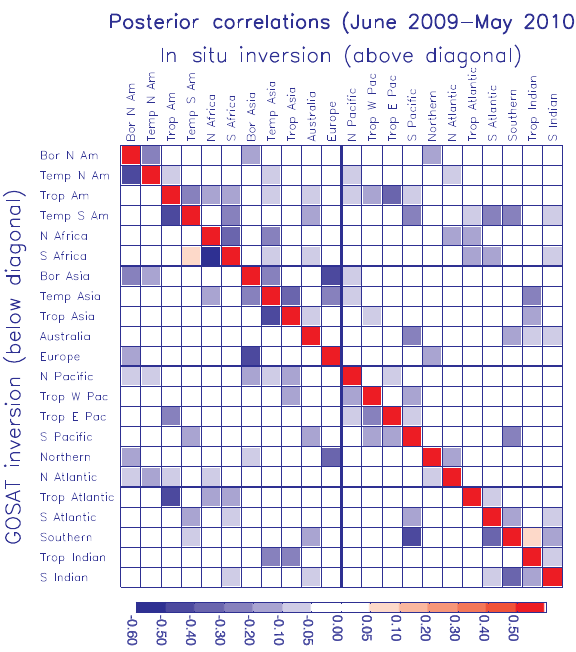
Figure 11. Posterior spatial flux error correlations, aggregated to TC3 regions and a 12-month period, for the in situ only inversion (for compactness, shown on and above the main diagonal), and the GOSAT only inversion (on and below the diagonal). The correla- tion is equal to the error covariance divided by the product of the corresponding flux uncertainties ( σ ). Values on the diagonal are equal to